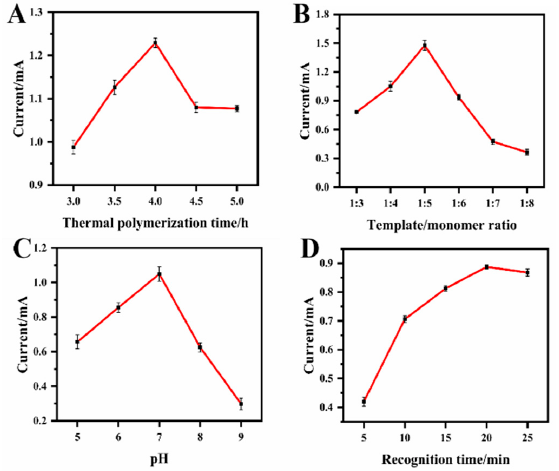
Figure 6. Plots of the oxidation currents of BPA versus ( A ) template/monomer ratio; ( B ) thermal polymerization time; ( C ) pH value of the detection solution and ( D ) elution time after the accumu- lation of 1.0 μ M